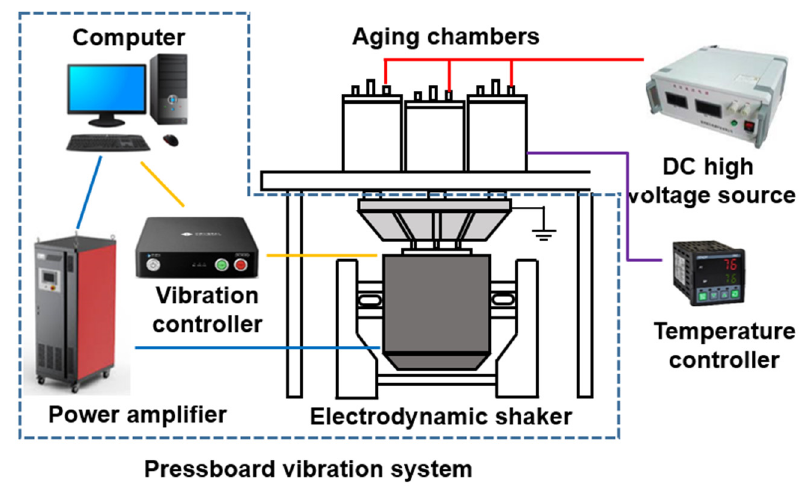
Figure 1. OIP multi-stress aging experimental setup.